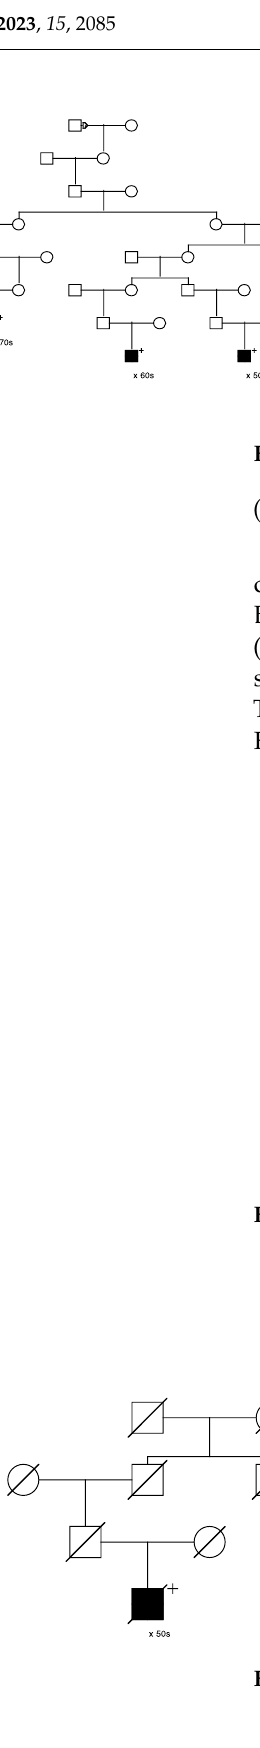
Figure 7. High-risk prostate cancer pedigree segregating a rare MSH6 variant. Figure 8 shows the single high-risk pedigree segregating a rare PTCH1 variant (seq_9_98240378_C- T_PTCH1). This variant is classified as “conflicting” in ClinVar. The founder of this pedigree was born in the mid-1800s with no recorded birthplace and has almost 4600 descendants in UPDB; a total of 33 prostate cancers were observed among all descendants, with 20.0 expected ( p = 0.0047). This pedigree also exhibits a significant ex- cess of breast cancer: a total of 37 breast cancers were observed in the entire descending pedigree, with 23.1 expected ( p = 0.0045). One of these breast cancer cases was the mother of a carrier, shown with half shading.